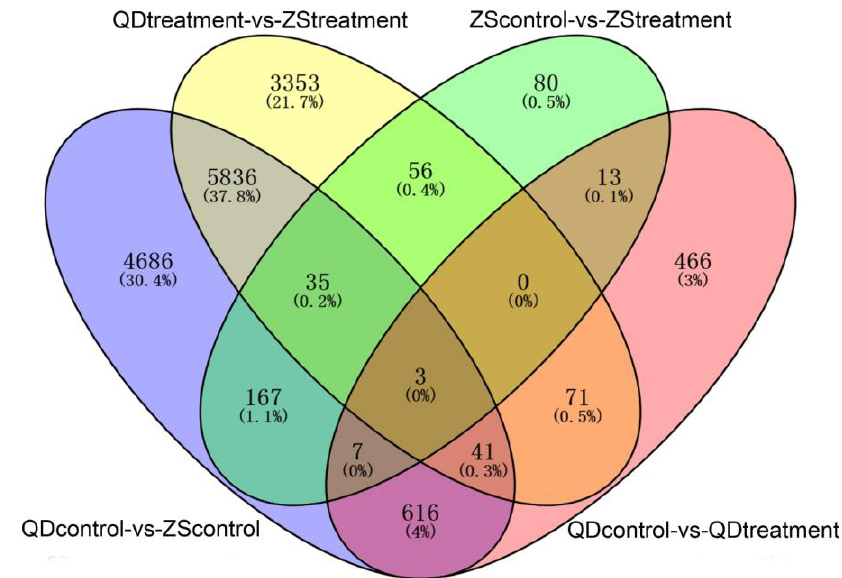
Figure 3. Global overview of the differentially expressed unigenes based on a Venn diagram (ZS control : Zhoushan population at 20 °C; ZS treatment : Zhoushan population at 28 °C; QD control : Qingdao population at 20 °C; QD treatment : Qingdao population at 28 °C).